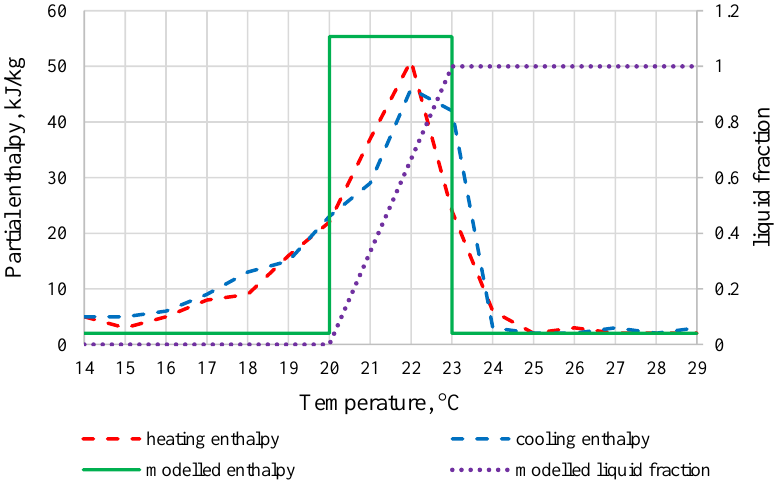
Fig. 5. Specific heat capacity and melting model of